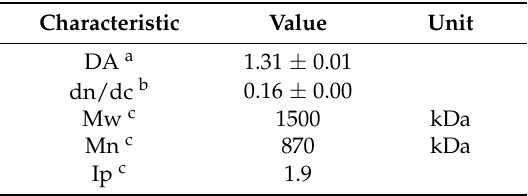
Table 1. Physical-chemical characteristics of AC. Characteristic